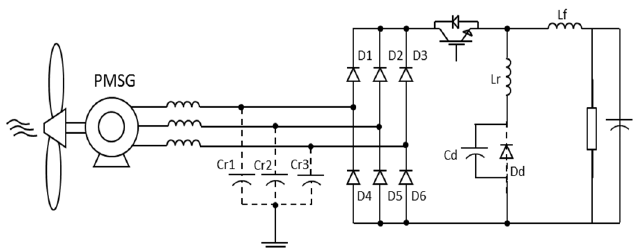
Figure 13. Equivalent circuit: Step 5.